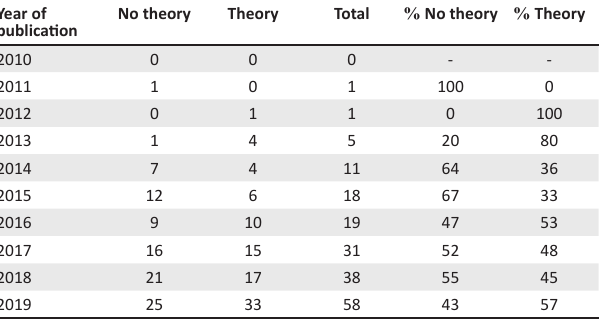
TABLE 2: Integrated reporting papers with and without theories in each year.